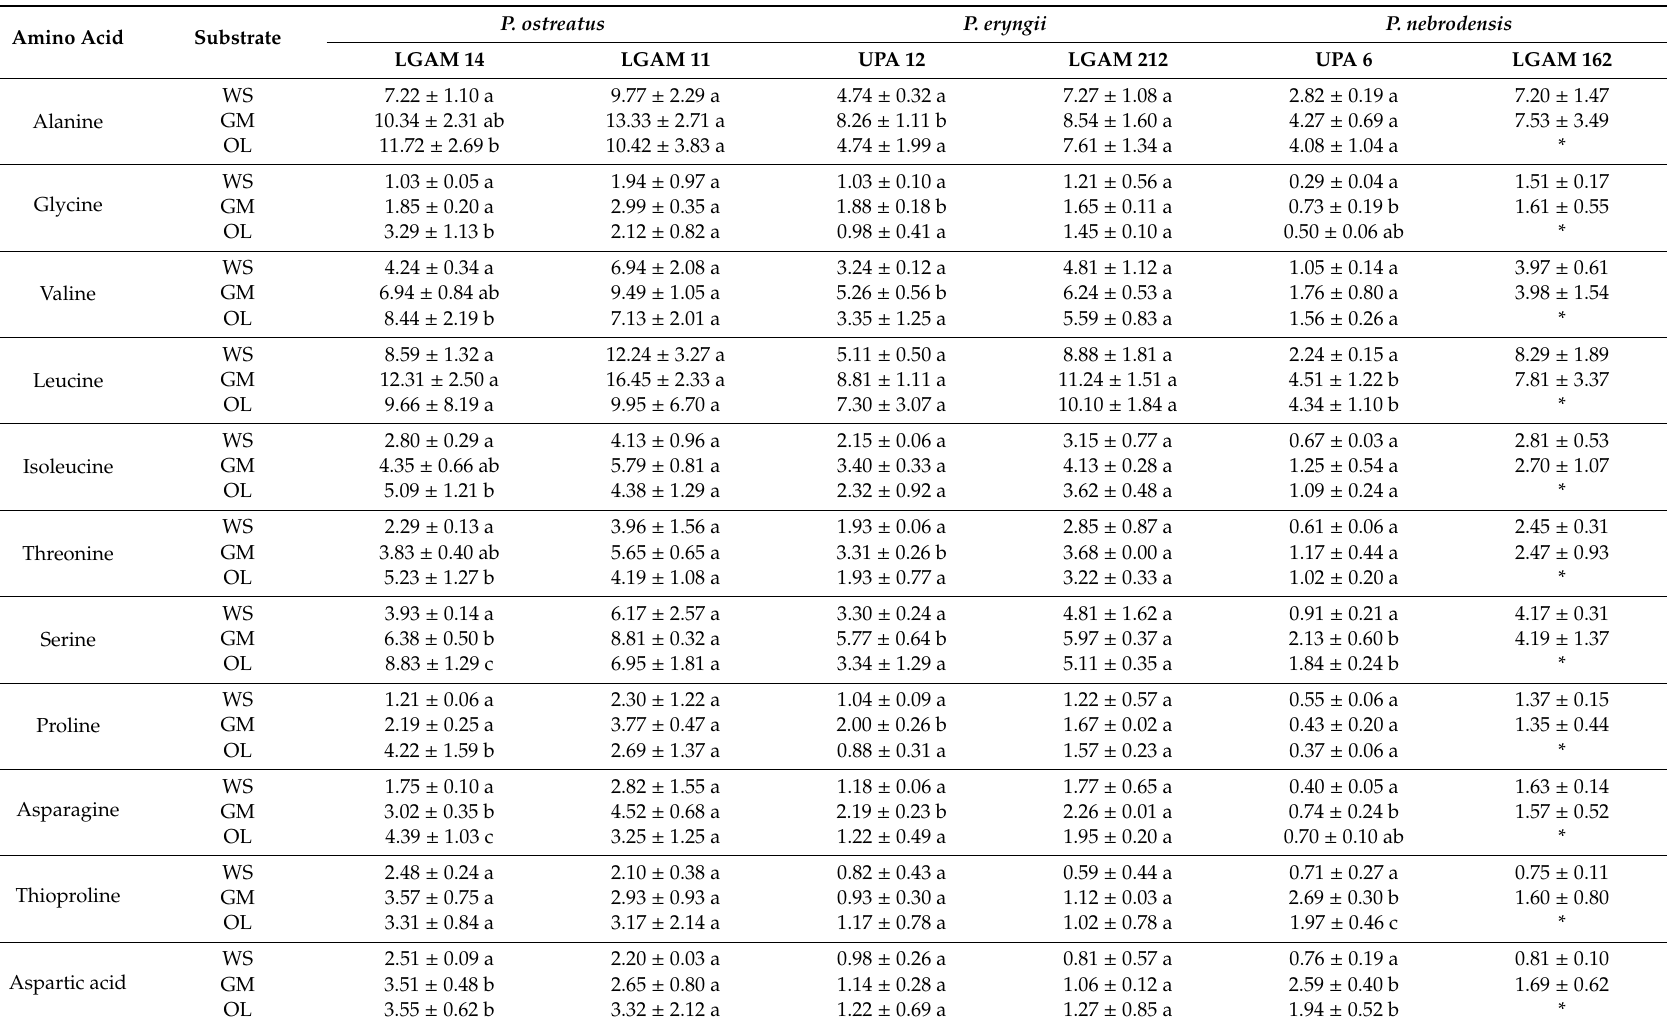
Table 3. Free amino acid and crude protein contents (mg / g dw) in mushrooms of Pleurotus ostreatus , P. eryngii and P. nebrodensis produced on three cultivation substrates. Amino